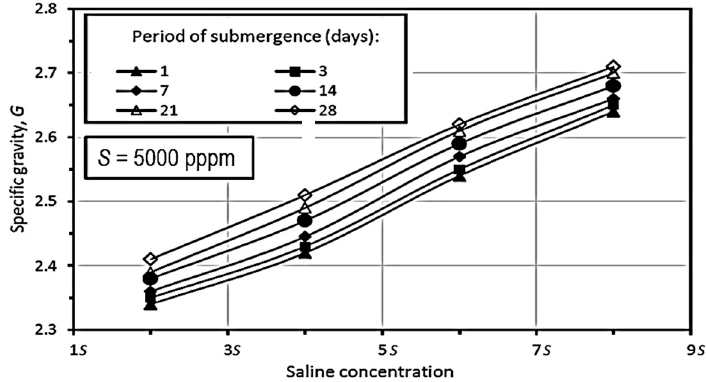
Figure 5. Variation of specific gravity with saline concentration.